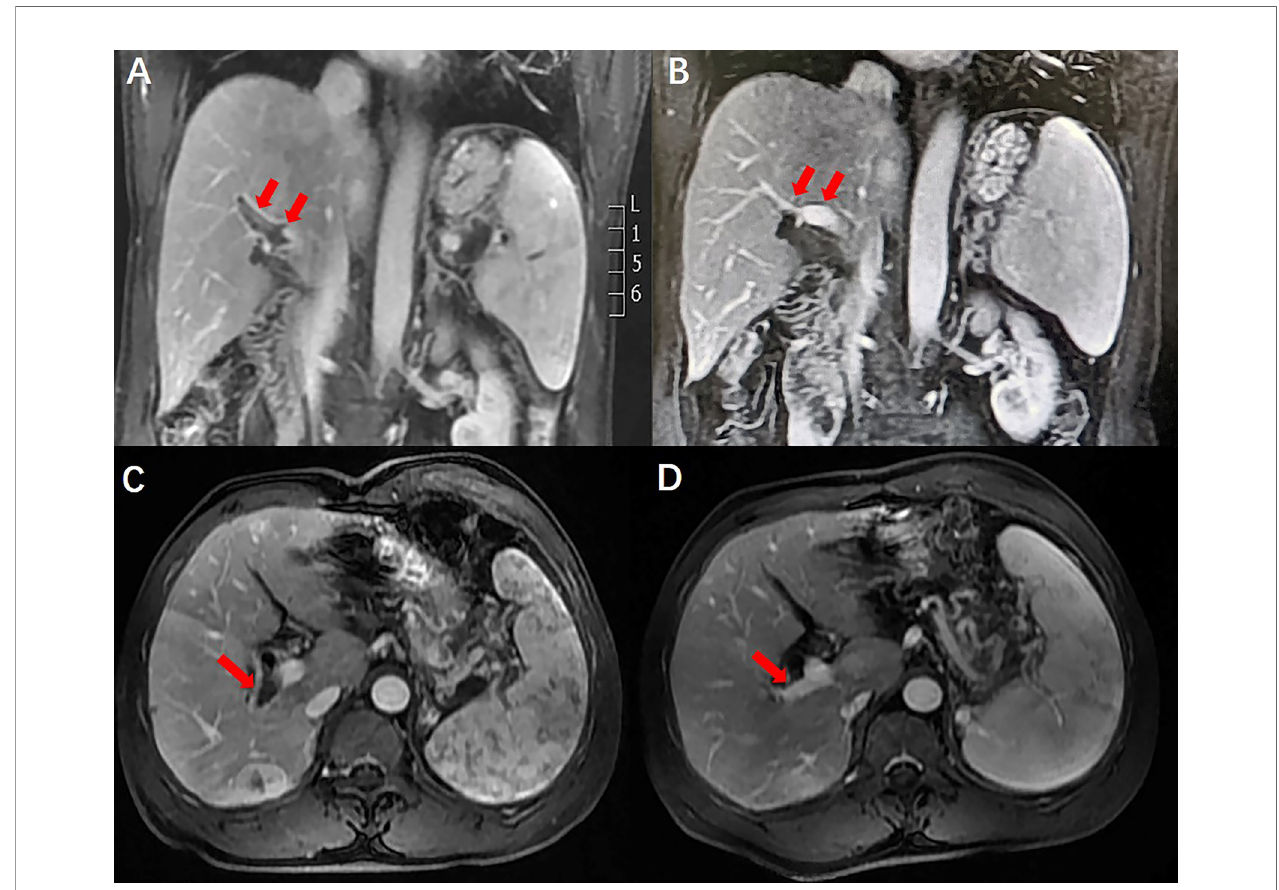
FIGURE 3 | Comparison of portal vein thrombosis before and after anticoagulant therapy. Portal vein thrombosis was recanalization.